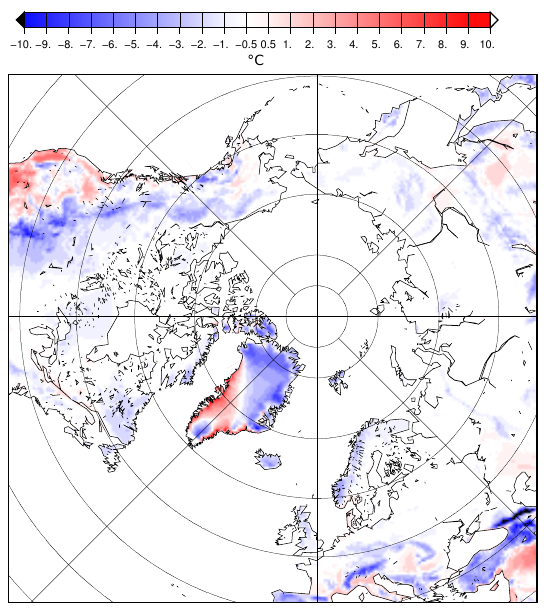
Figure 6. Annual mean temperature anomaly due to the down- scaling procedure, in degrees, computed as the difference between the downscaled temperature and the interpolated temperature fields. This is one example taken from one particular year.